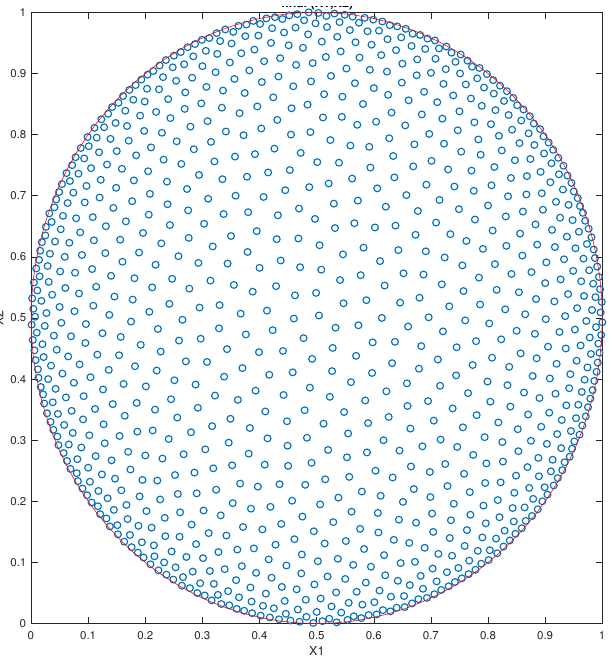
Figure 3: An illustration of the bivariate spherical symmetric copula C